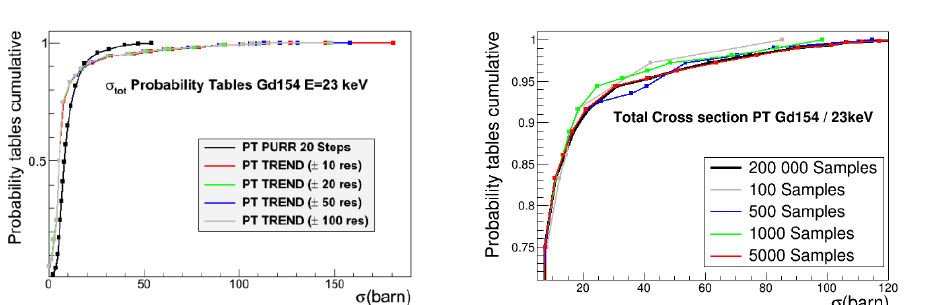
Fig. 5. 5a (left): Comparison of probability table cumulative distributions from PURR and GTREND using various numbers of resonances. 5b (right): Comparison of probability table cumulative distributions calculated with GTREND as a function of the number of resonance